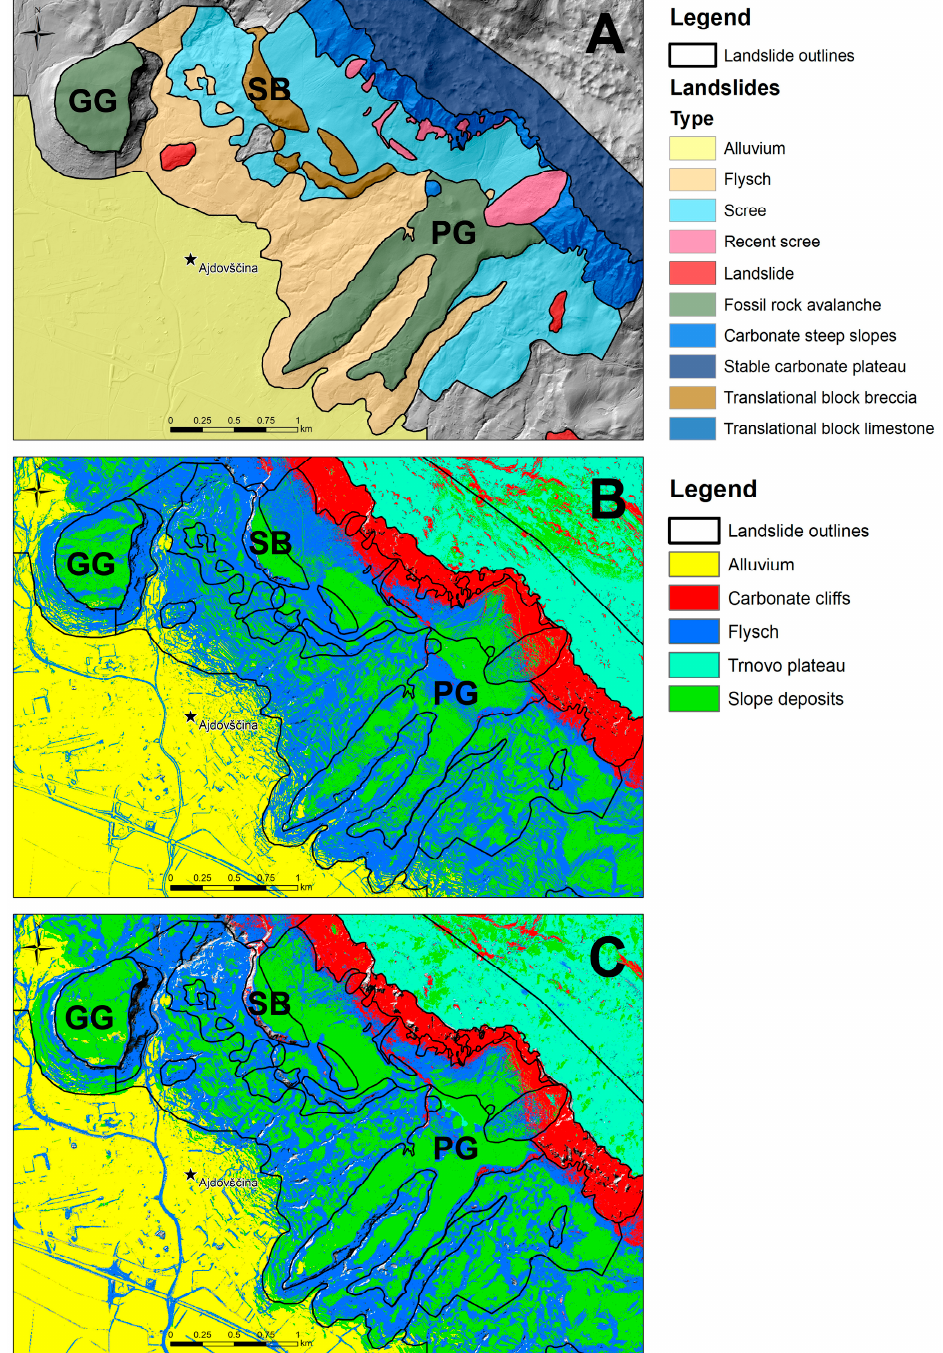
Figure 5. Podrta gora area. ( A ) outlines and main sediments of the landslides and litho-geomorphological units; ( B ) original MLC results [34]; and ( C ) results from this study.